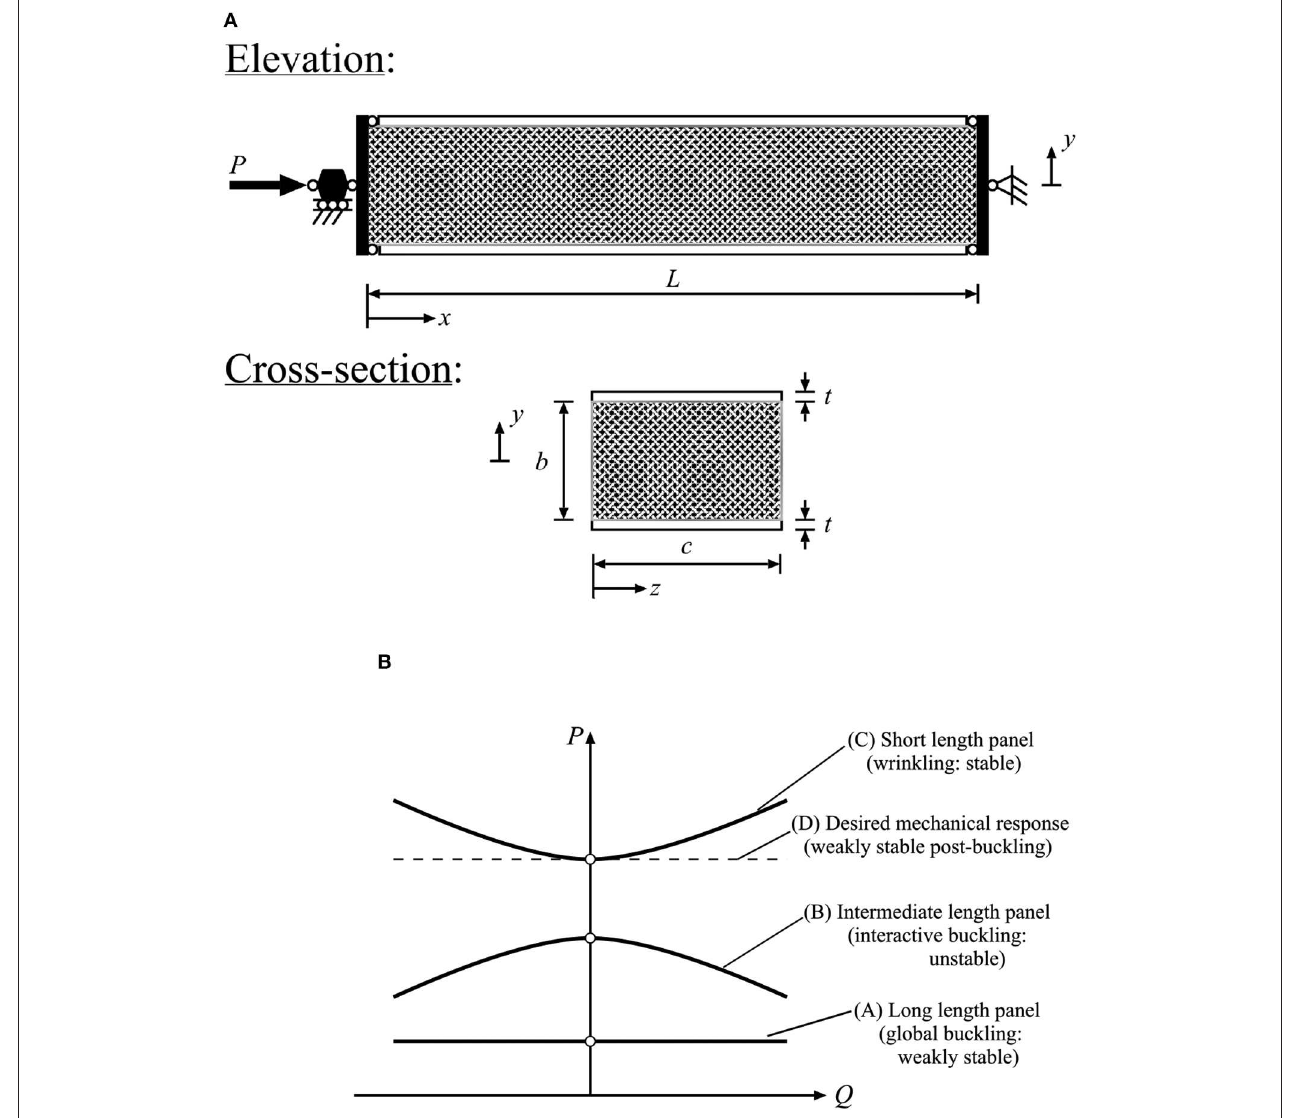
FIGURE 2 | (A) Axially compressed simply-supported sandwich panel (a strut in this case) of length L , breadth c , core depth b and face plate thickness t . (B) Schematic of equilibrium paths of load P vs. a reference deflection Q for sandwich panels of various